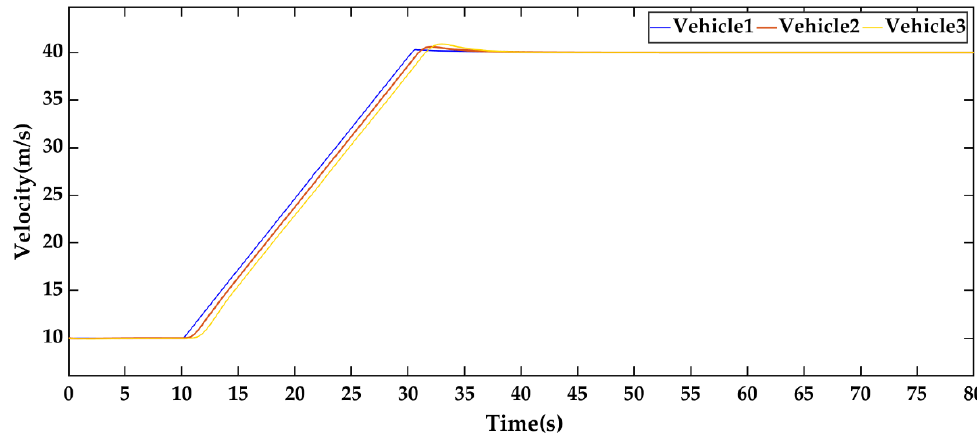
Figure 9. The velocities of the following vehicle under the standard MPC strategy in Scenario 1.